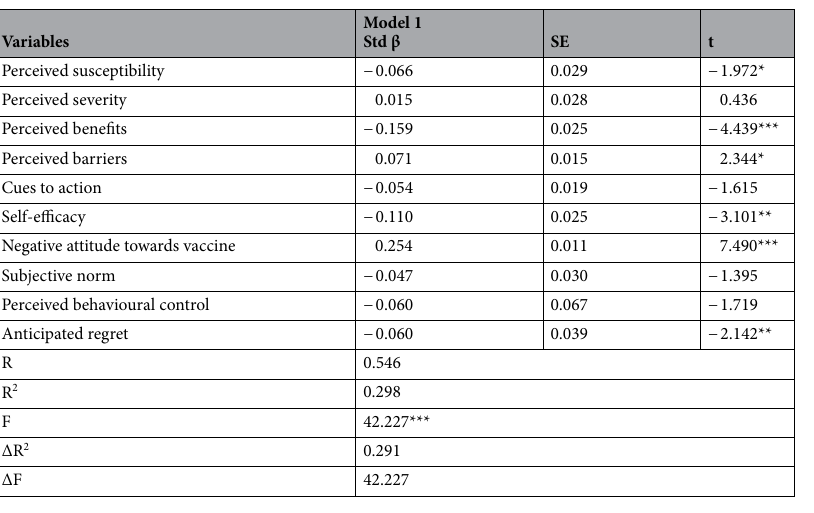
Table 5. Multiple linear regression analysis—the six domains of health belief model and four domains of the theory of planned behaviour as a predictor of vaccine hesitancy. HBM dimensions: perceived susceptibility, perceived severity, perceived benefits, Perceived barriers, cues to action and self-efficacy; TPB dimensions: Negative attitude towards vaccine, subjective norms, perceived behavioural control and anticipated regret; Std β—standardised beta or regression co-efficient; t—t value, R—represents the correlation; R 2 —variance in the outcome explained in the model; F—F ratio. * p < 0.05; ** p < 0.01; * ** p <